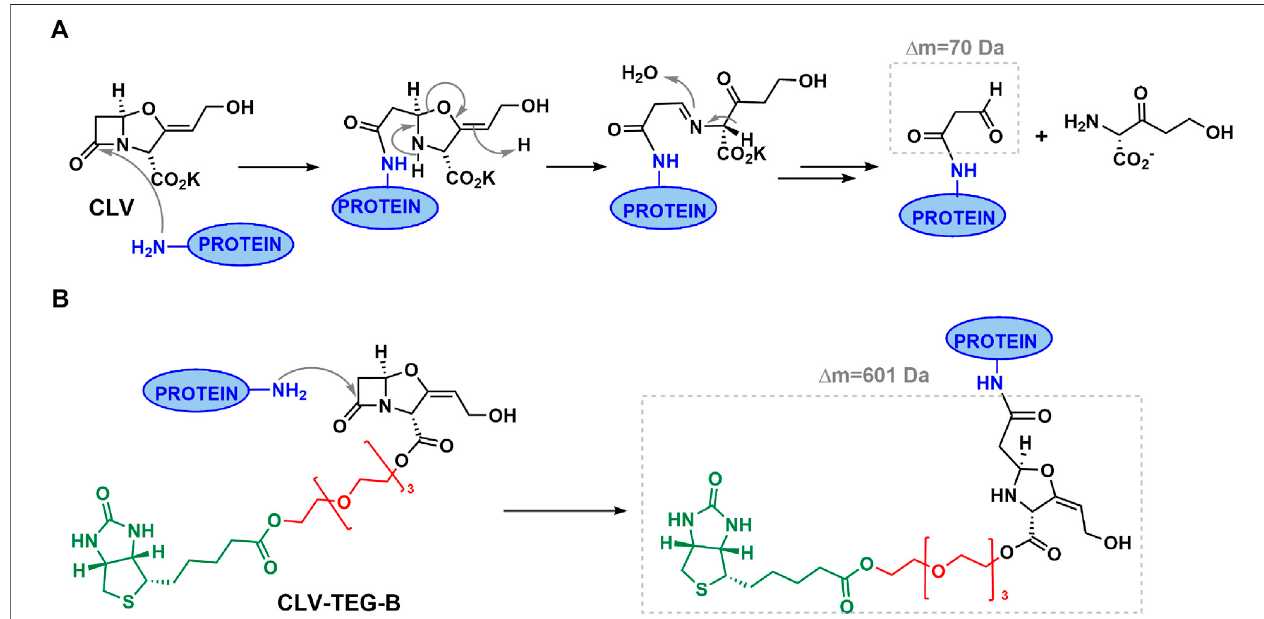
FIGURE6| Hypothesizedmechanismsforproteinconjugationwithclavulanicacid(CLV)derivatives. (A) ProposedreactionmechanismforcovalentbindingofCLV to proteins leading to an unstable structure that can degrade through different pathways resulting in different determinants. Represented only the structure of identi fi ed potential antigenic determinant (N -protein, 3-oxopropanamide). (B) Proposed reaction mechanism for binding of CLV-tetraethylenglycol-Biotin to proteins leading to a stable conjugate structure. Theorycal increment of mass added to protein is indicated in each case (see text for details).